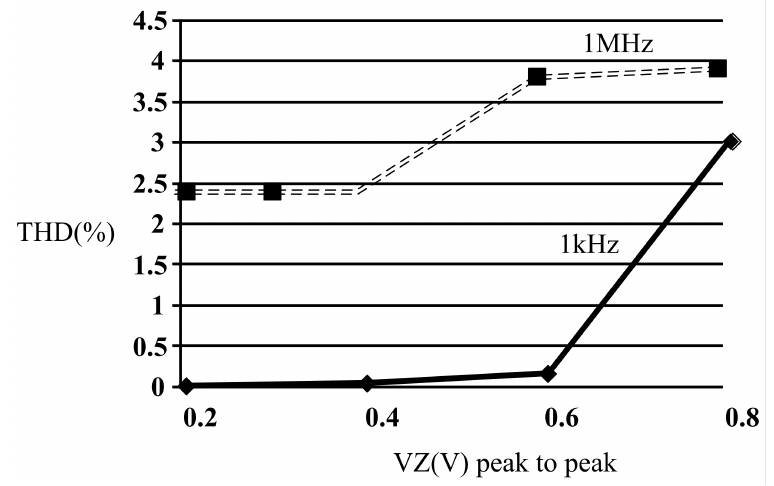
Figure 13. THD for different amplitudes of V Z at frequencies of 1 kHz and 1